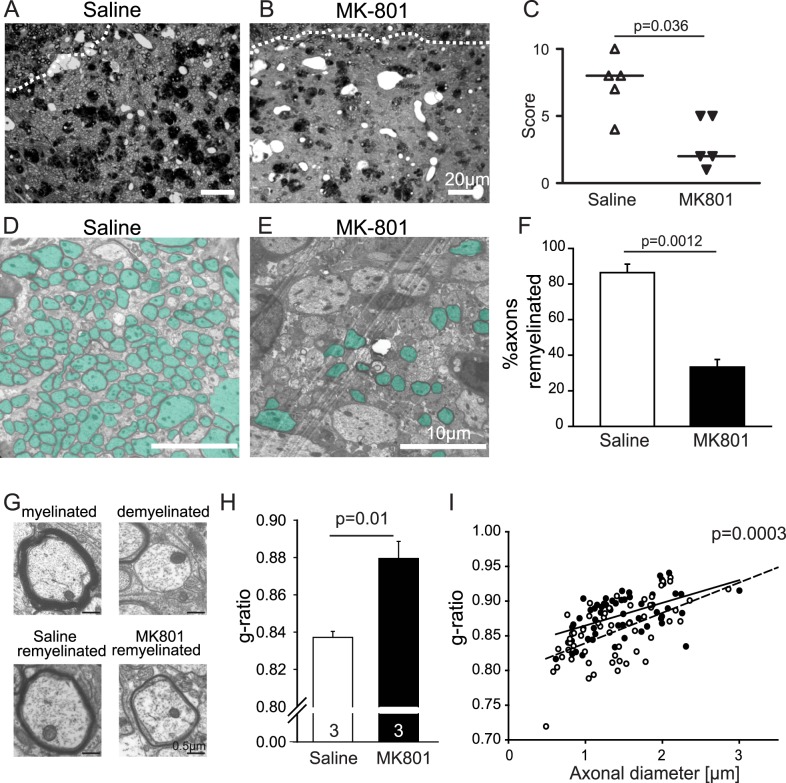
Remyelination is dependent on NMDA receptor activation.(A–B) Semithin sections of lesioned caudal cerebellar peduncle (CCP), 21 d postlesion, infused with saline (A) or MK-801 (50 µM; B) for 18 d. The dotted white lines mark the lesion edge. (C) Ranking of remyelination; each symbol represents one animal. Higher ranks represent more remyelination. The p value from Mann–Whitney U test. (D, E) Higher magnification picture shows that fewer axons are remyelinated in lesions treated with MK-801 (remyelinated axons are coloured green). (F) Mean percentage of axons remyelinated averaged over 20 areas in each of three lesions for each condition. (G) Specimen images of a normal myelinated axon, a demyelinated axon, and remyelinated axons in lesions infused with saline or MK-801. (H–I) Mean g-ratio of all axons, and mean g-ratio at all diameters, are higher with MK-801 present (student t test, n = 3).